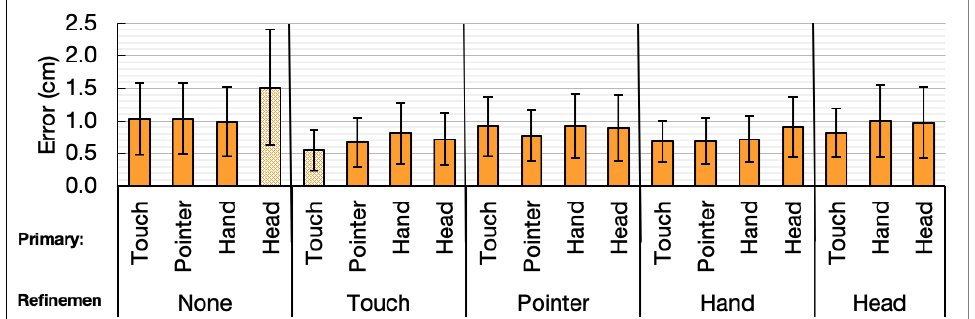
Figure 7. Mean pointing error with different interaction techniques. Error bars represent the standard deviations and the pattern-filled bars annotate the most and the least accurate technique.